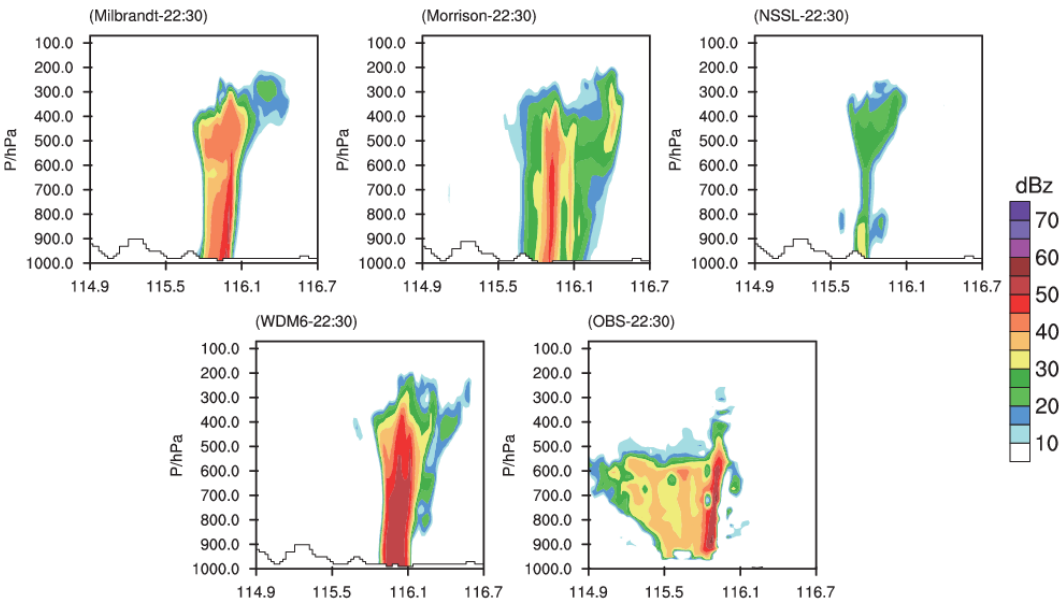
Figure 10. The vertical cross section of observed and simulated radar reflectivity across the blue line in Figure 9 at 2230 UTC 15 April 2016 (shaded, units: dBz).